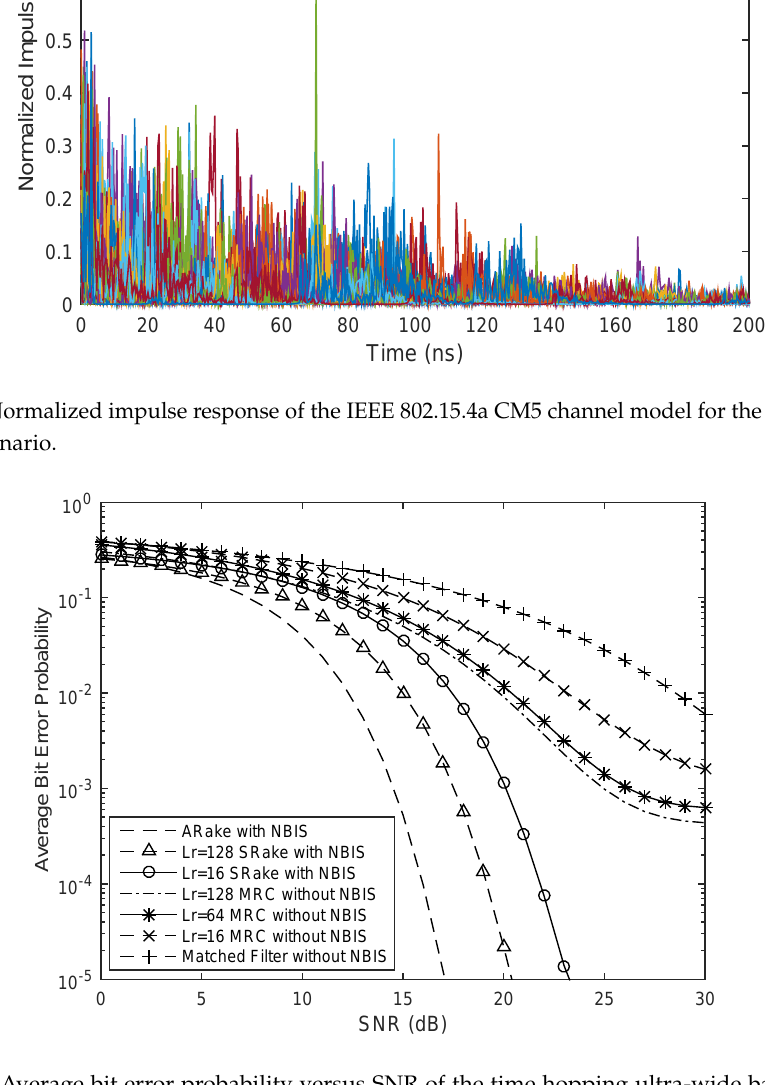
Figure 10. Average bit error probability versus SNR of the time hopping ultra-wide band wireless sensors receiver considered with and without the proposed narrow band interference (NBI)